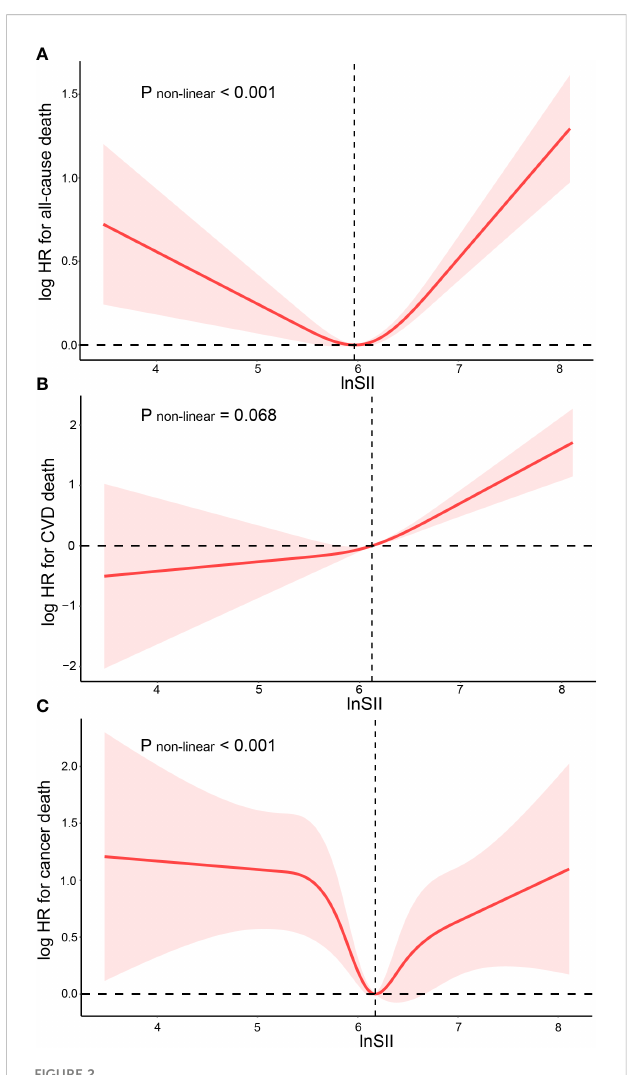
FIGURE 2 Restricted cubic spline fi tting for the association between SII with mortality. Association of SII levels with the all-cause (A) , CVD mortality (B) and cancer mortality (C) .